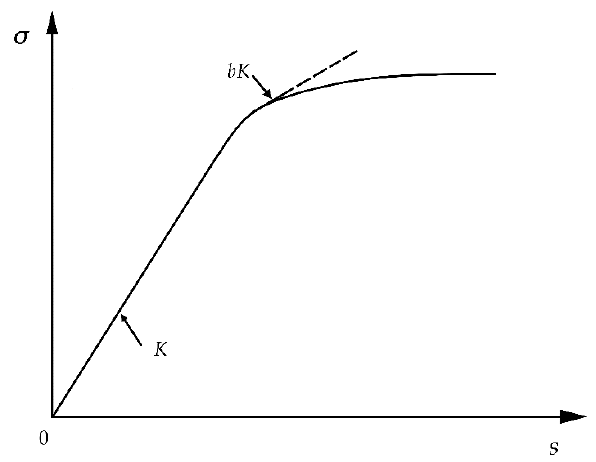
Figure 2. The bar stress versus loaded-end slip relationship for the zero-length element.